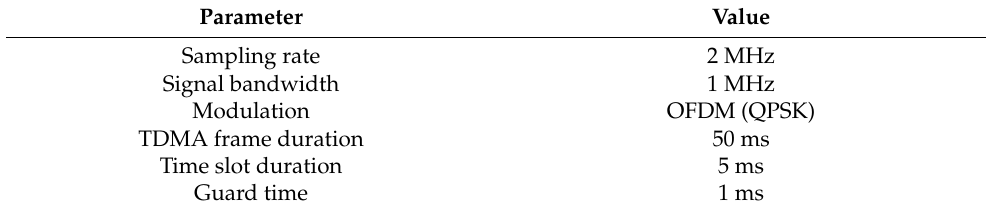
Table 1. Cognitive waveform